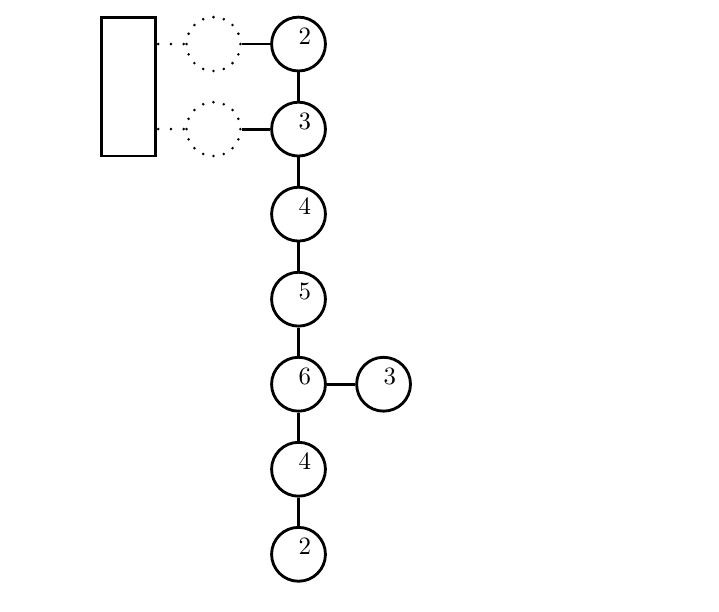
Figure 13. Quiver diagram for E 8 theory. We also need G-string in the global construction. The same conventions as